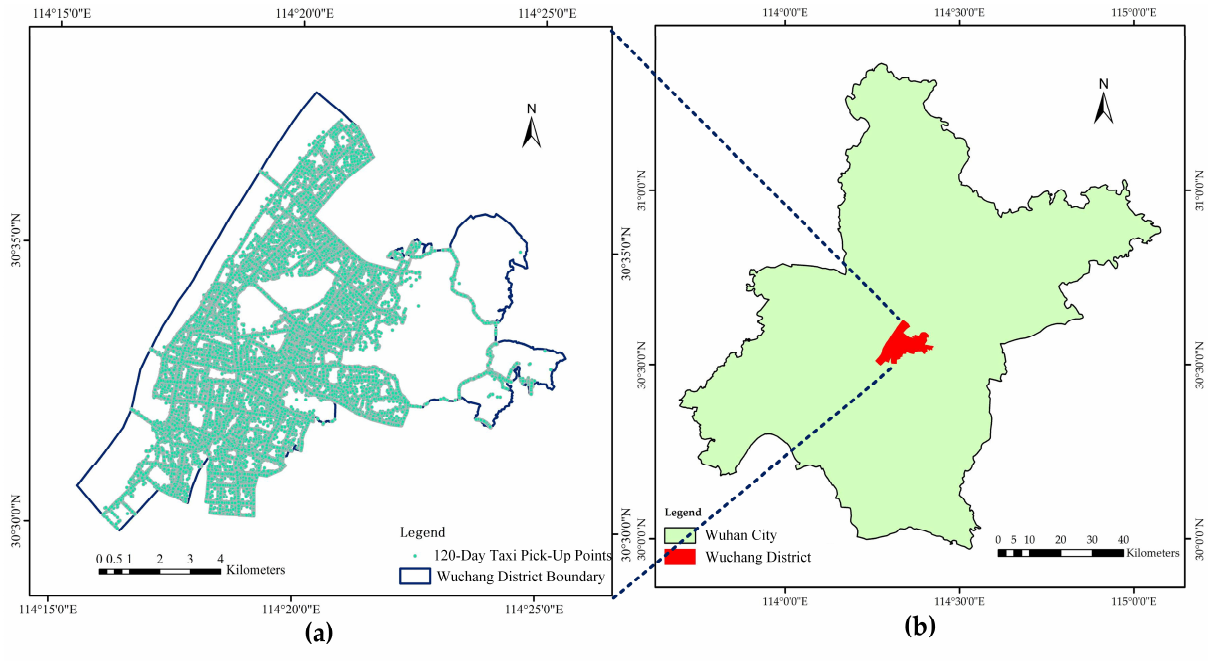
Figure 1. Study area.